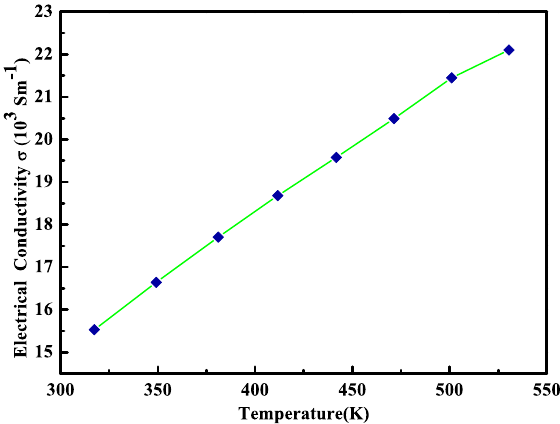
Figure 8. Temperature dependence of the electrical conductivity σ .